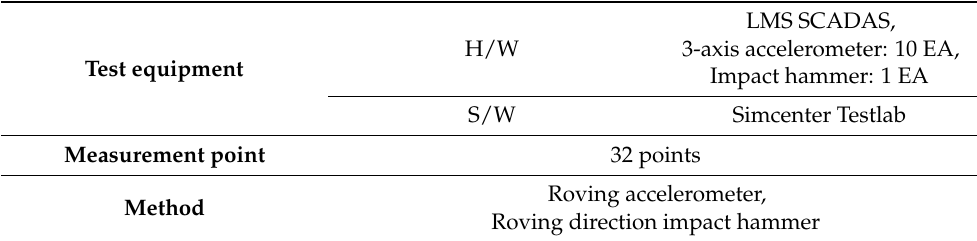
Table 6. Methods and equipment for performing modal